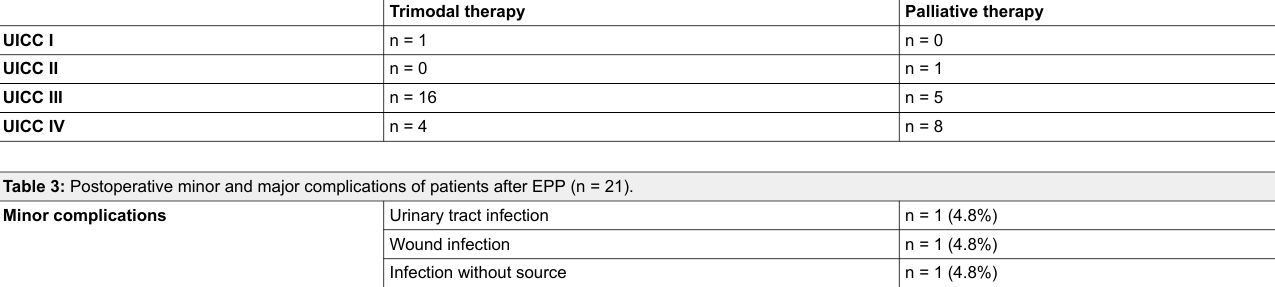
Table 2: Postoperative tumour staging according to the Union of International Cancer Control (UICC) classification [35]. Trimodal therapy